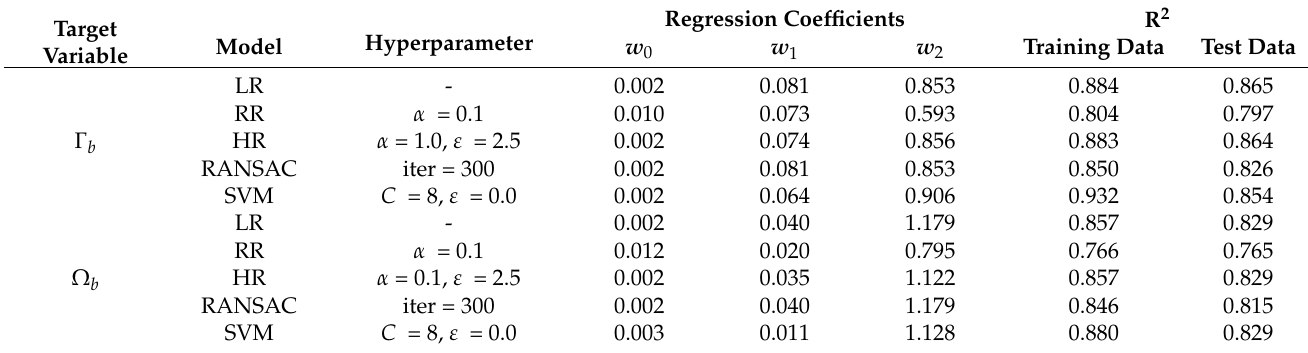
Table 4. Summary of ML training and prediction results for breaker